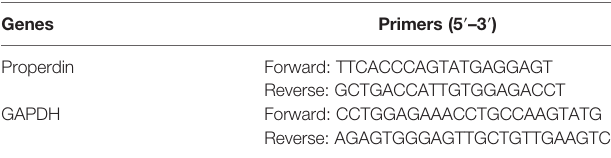
TABLE 1 | The sequence of primers for real-time quantitative